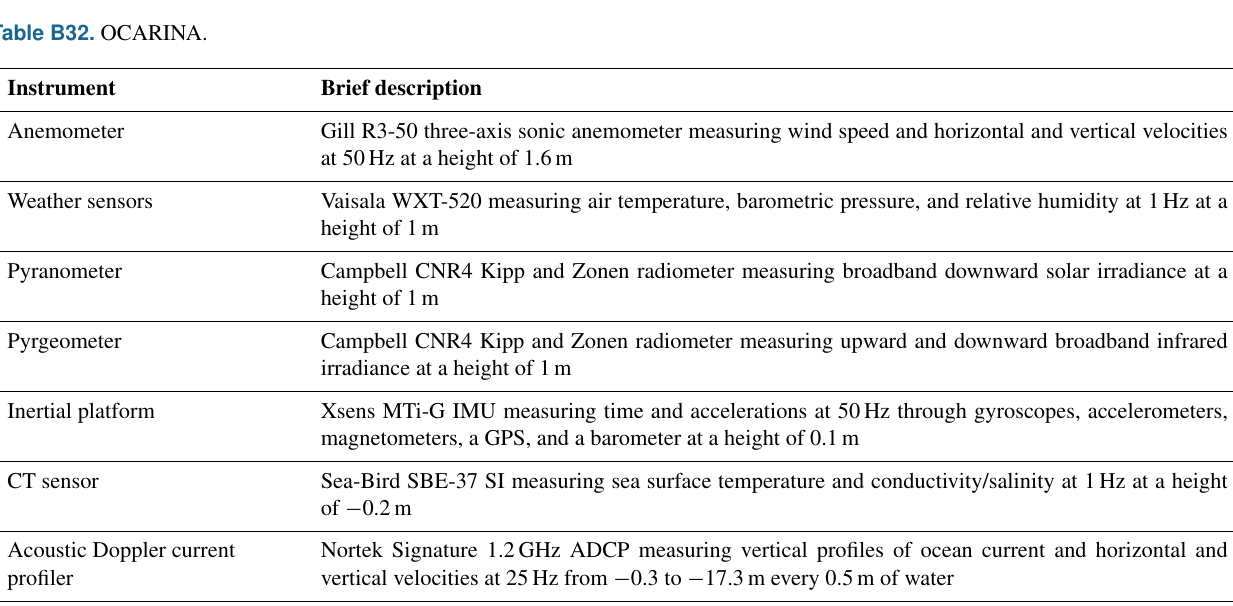
Table B32. OCARINA.